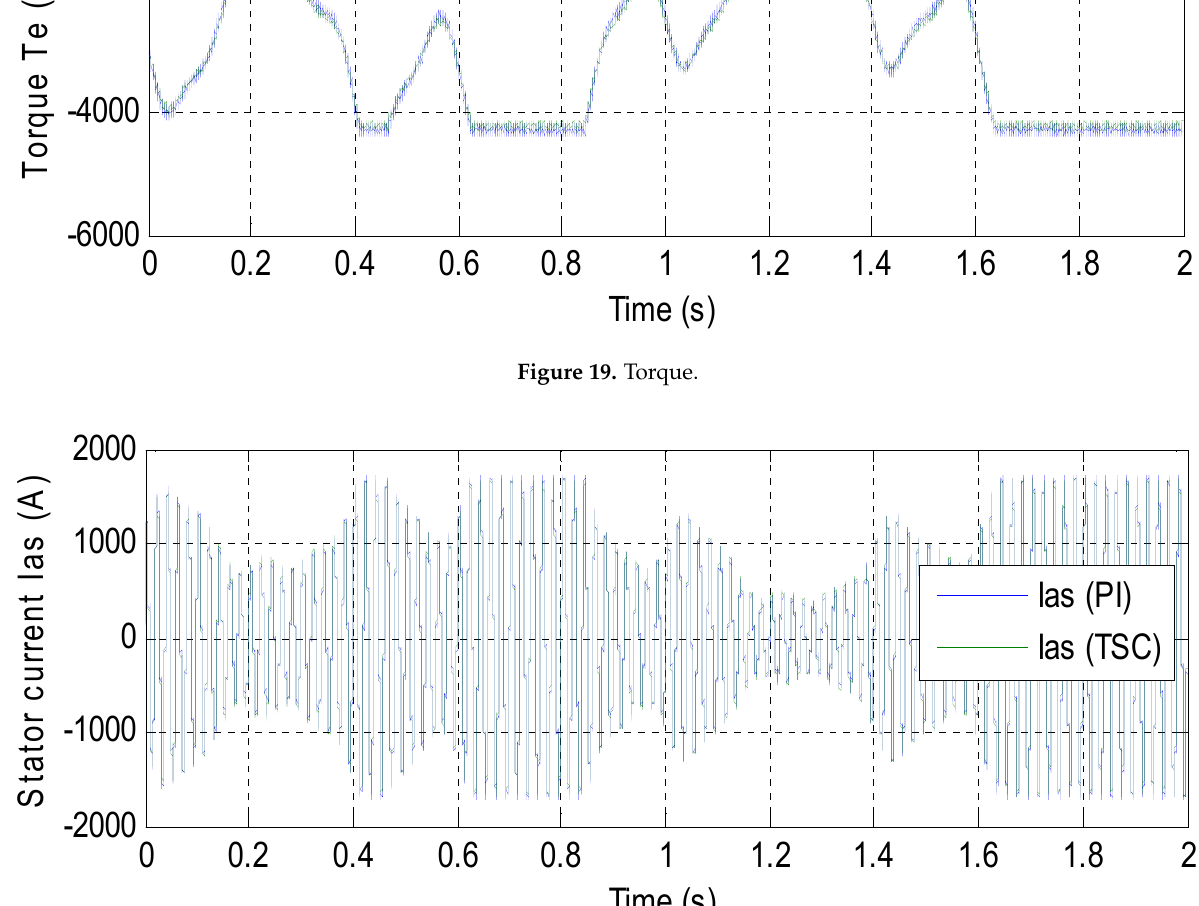
Figure 20. Current. Figure 20.